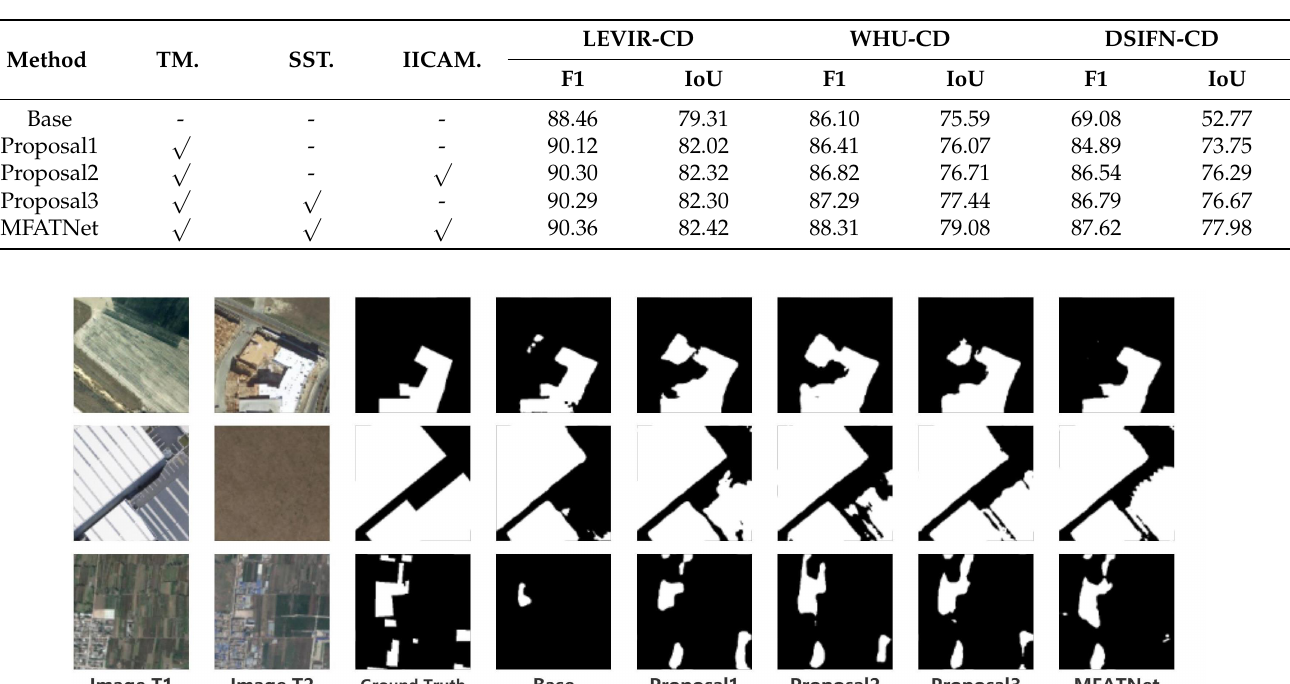
Figure 7. From top to bottom once are comparative figures of the LEVIR-CD, WHU-CD, and